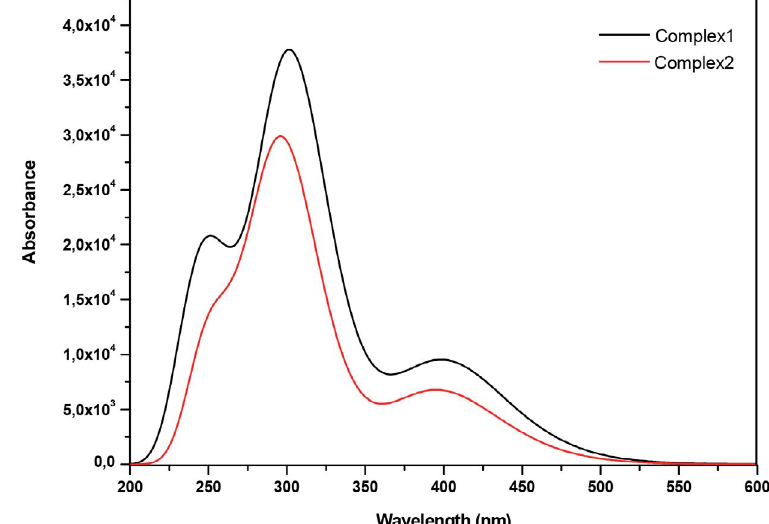
Figure 3. The theoretical UV-Vis spectra for two Mo complexes.